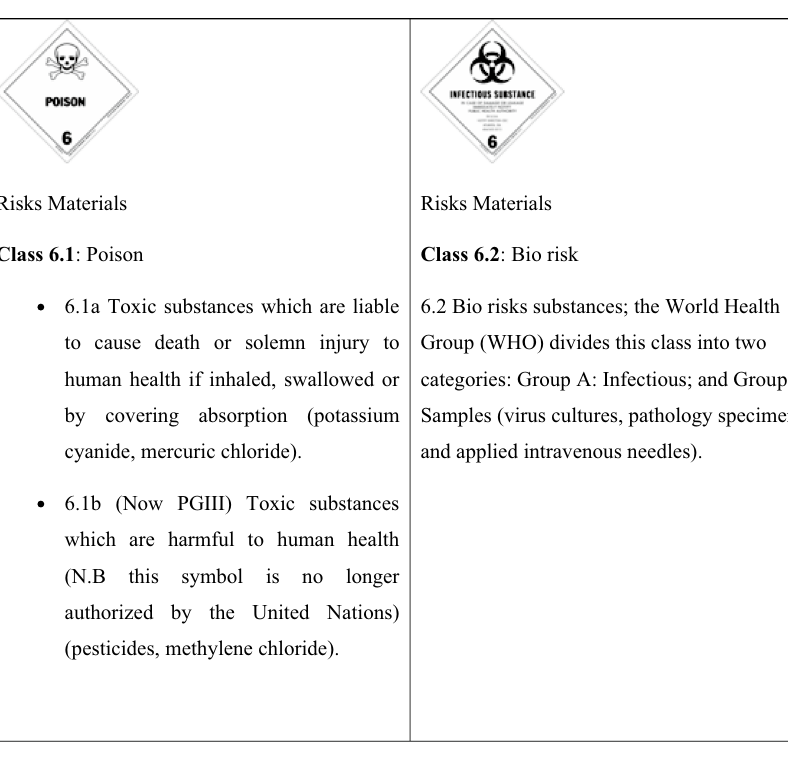
Fig. 7 Radioactive substances, corrosive substances, miscel-